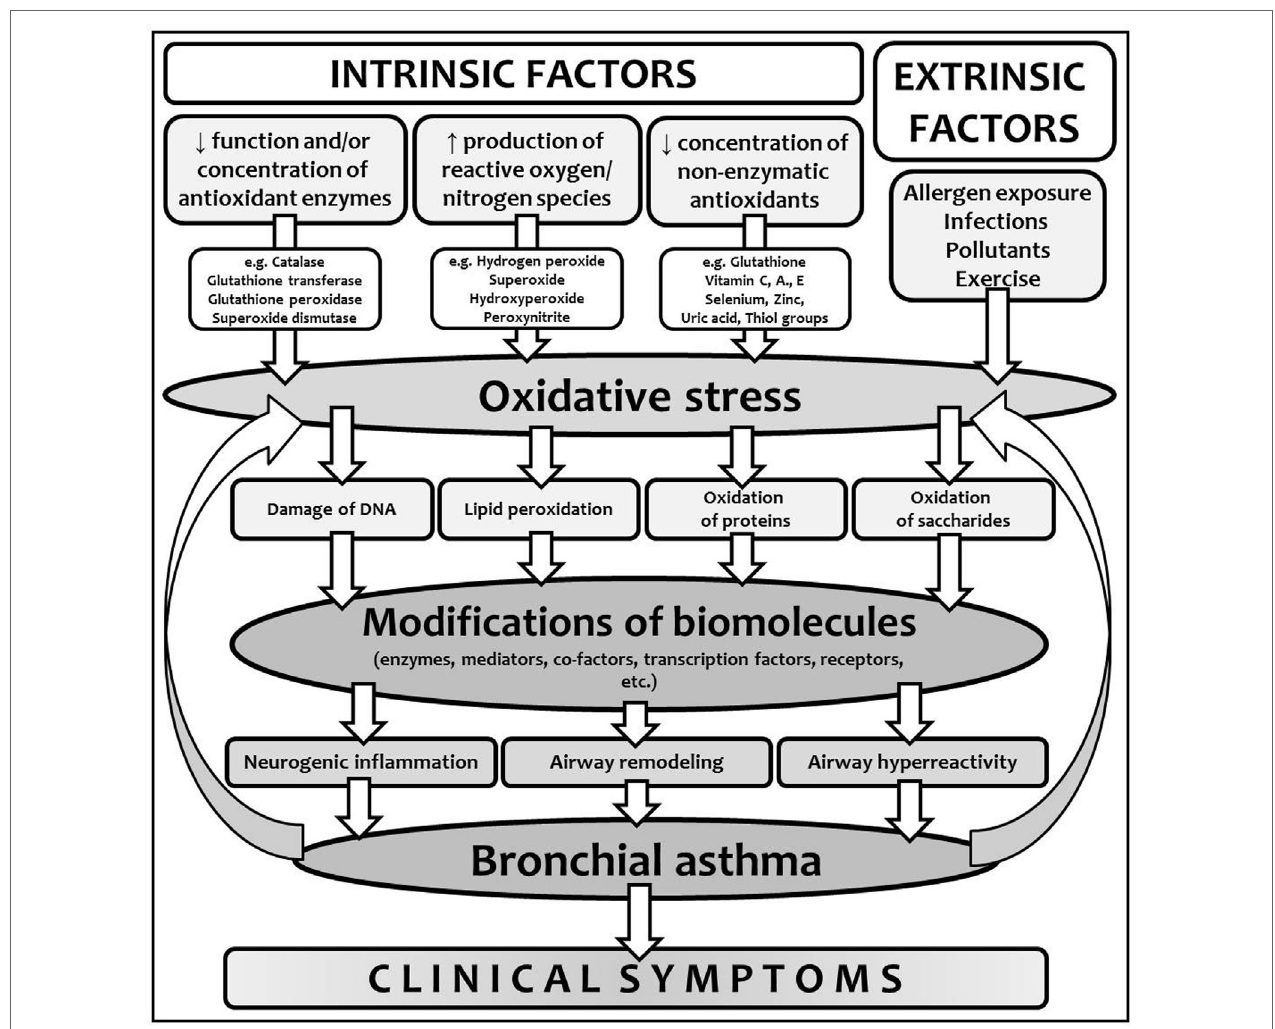
FigURe 2 | Oxidative stress in the context of bronchial asthma development. Interplay between intrinsic and extrinsic factors leads to the production of reactive oxygen species (ROS) and in certain conditions, due to the imbalance between the production of ROS and antioxidant defense, oxidative stress and modification of biomolecules develops. Due to the modifications of various biomolecules with different functions, particular components of chronic inflammation lead to asthma development and clinical symptoms onset. Moreover, non-controlled or partially controlled and regulated inflammation is another important source of ROS, which closes the vicious